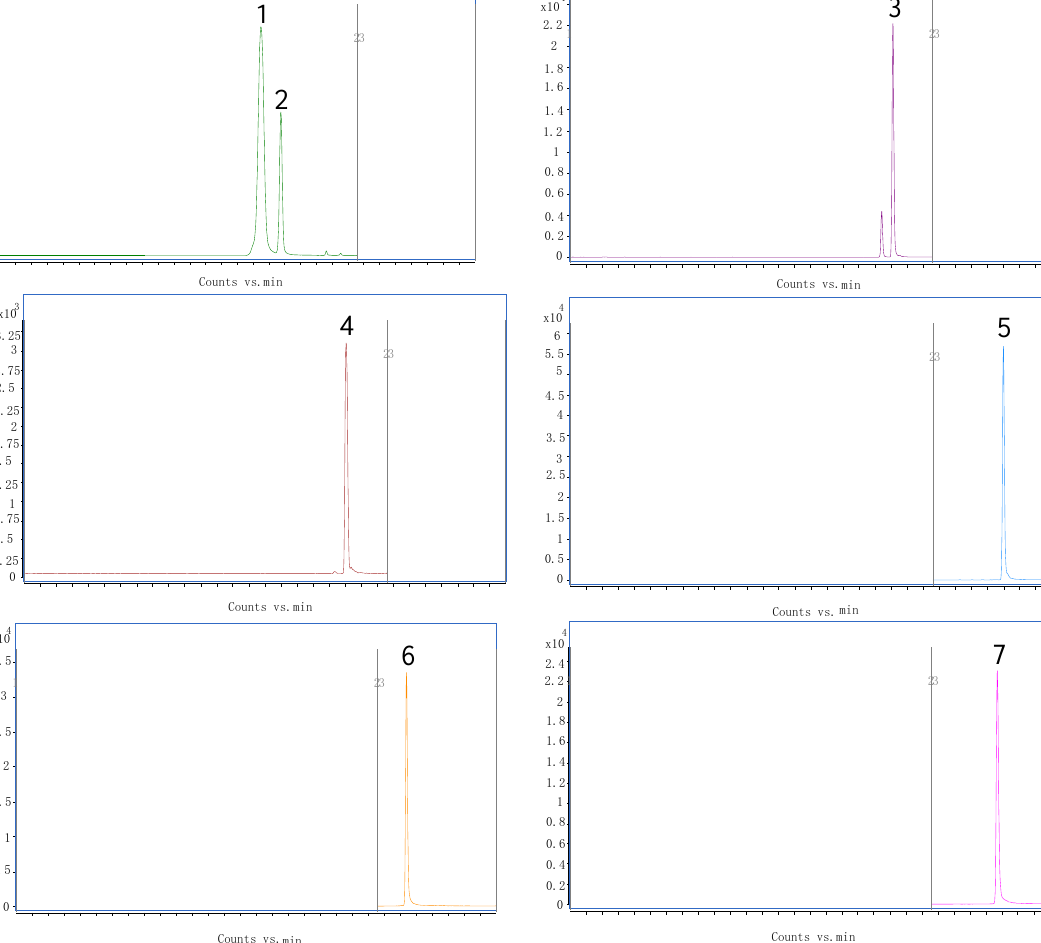
Figure 2. Chromatographic of flavonoid standards. Note: 1. Hyperoside 2. Isoquercitrin 3. Astragalin 4. Luteolin-7- O -glucoside 5. Isorhamnetin 6. Quercetin 7. Kaempferol.